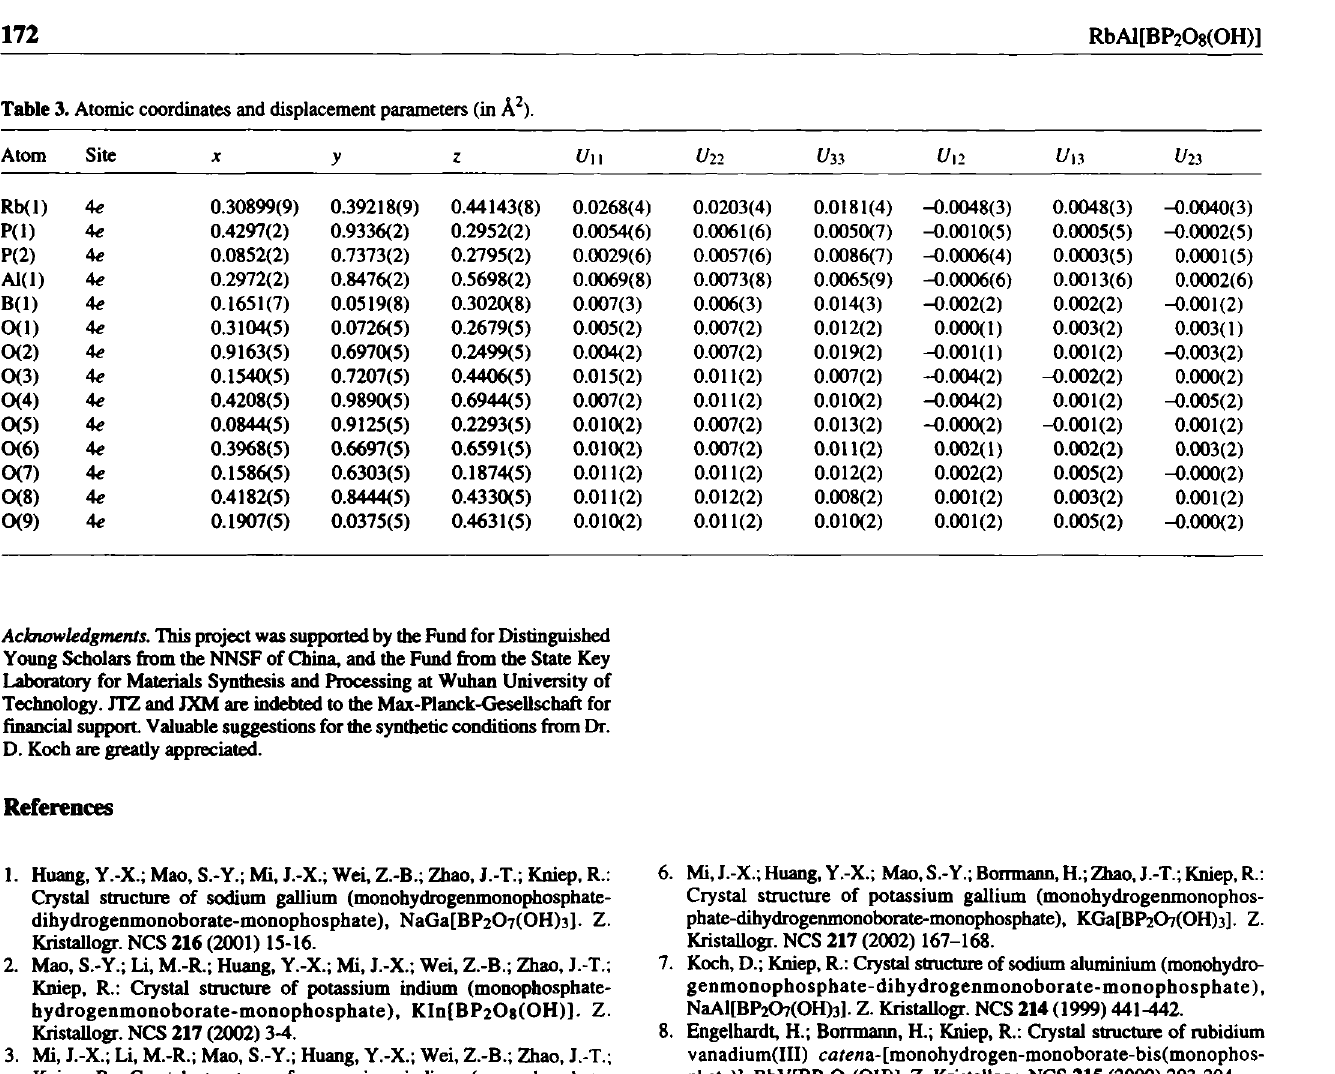
Table 3. Atomic coordinates and displacement parameters (in Â 2